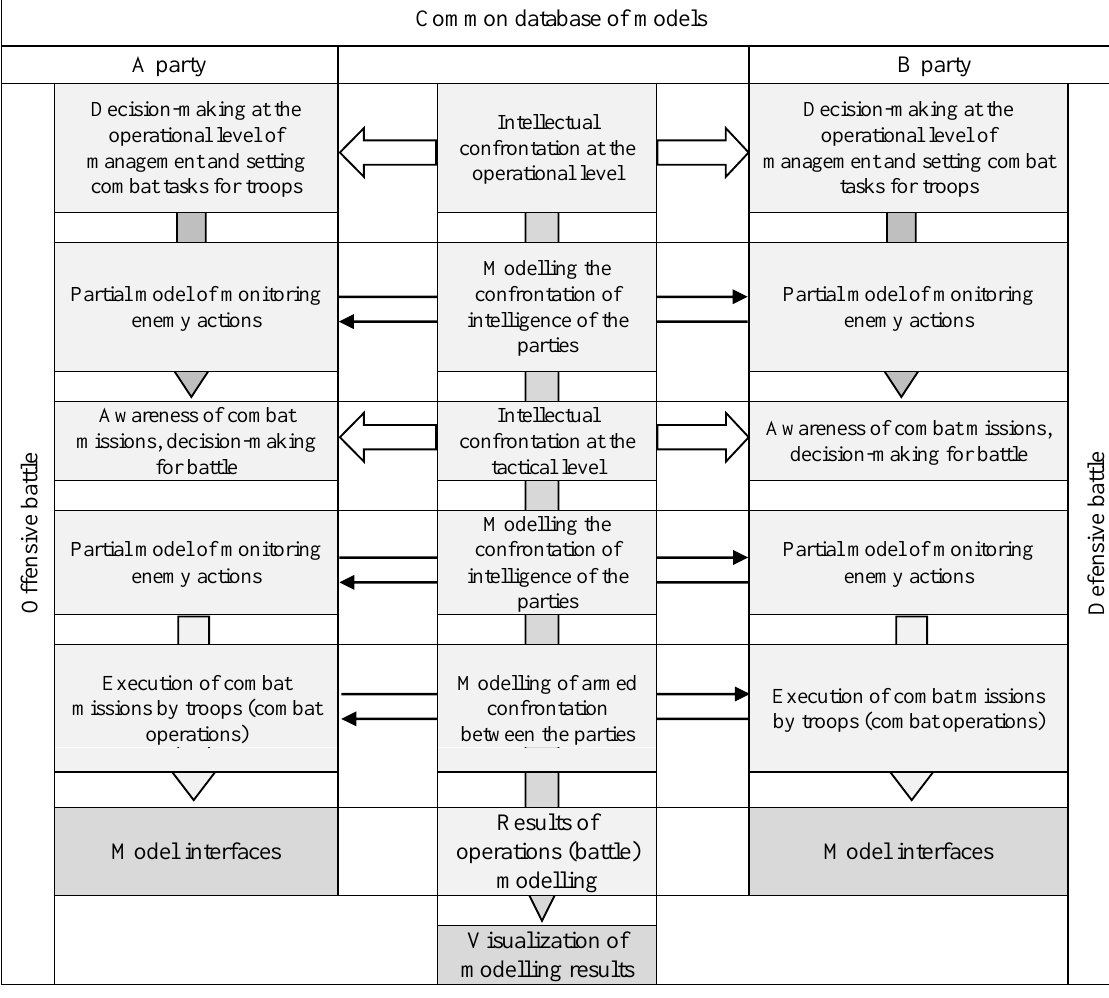
Figure 2. The structure of combat operations model, taking into account the intellectual confrontation of the